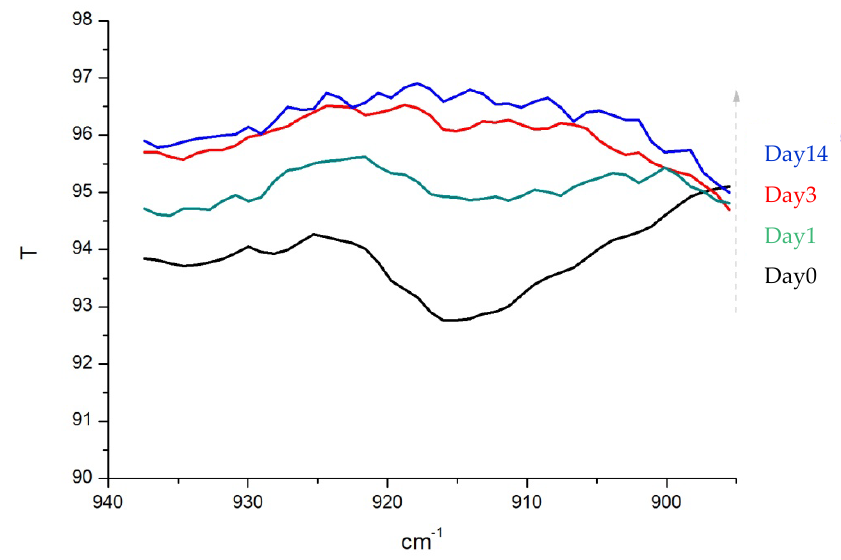
Figure 12. Variation in IR signal intensity of CH-O-CH 2 bending as aging time increases .